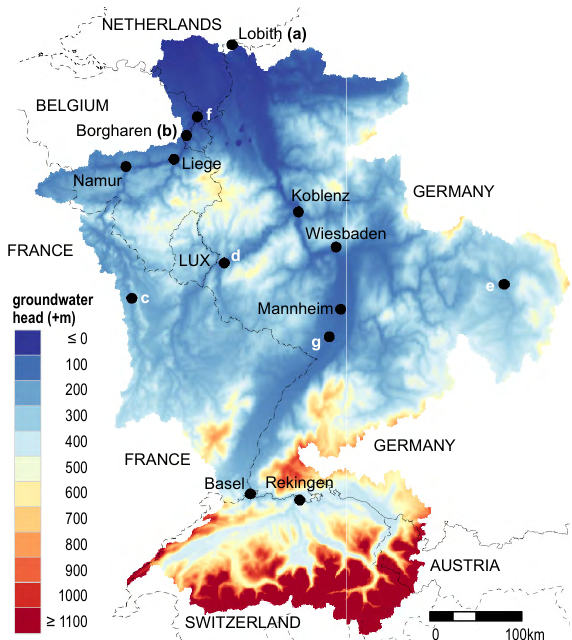
Fig. 4. The average calculated groundwater head for the period 1974–2008, based on the reference scenario A01.0 B01.0. The al- phabetical codes shown on the maps indicate the measurement sta- tion locations for the graphs in Fig.